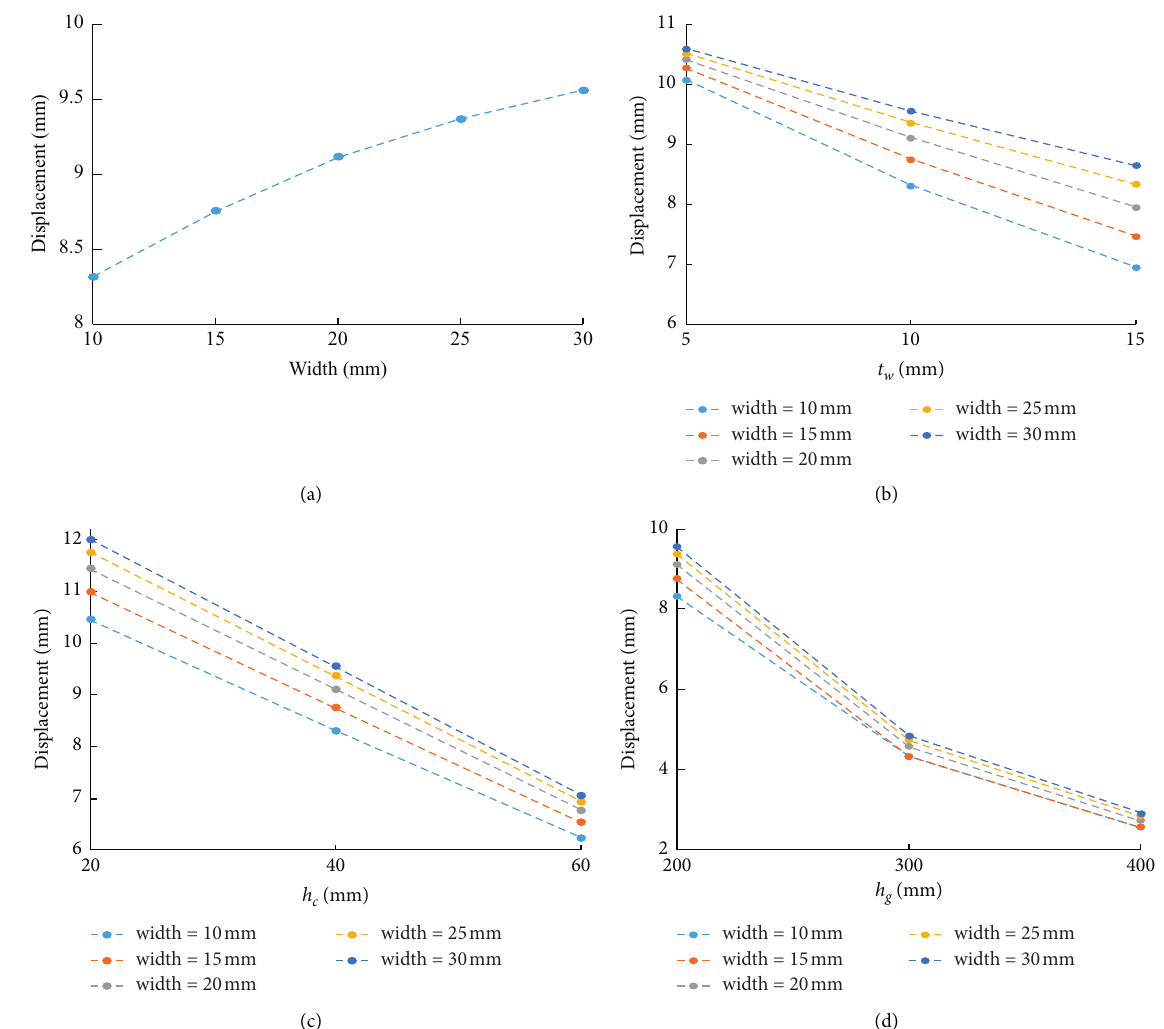
Figure 16: Displacement of the two I-shaped GFRP with corrugated webs-concrete hybrid girder.